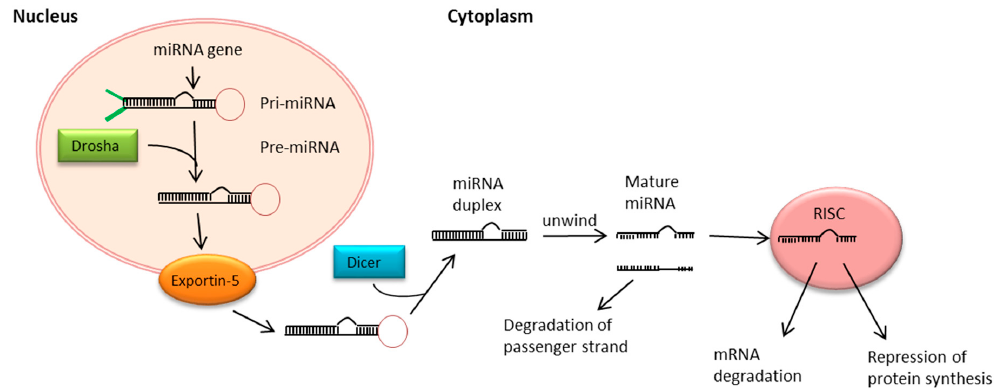
Figure 2. MicroRNA biogenesis and processing pathway. Arrows are indicating the way how microRNAs are processed and how they influence protein expression. Primary-miRNA (pri-miRNA) is transcribed from DNA and cleaved into precursor-miRNA (pre-miRNA), which is exported into the cytoplasm by Exportin-5 for further processing. The mature microRNA (miRNA) strand is assembled into the RNA-induced silencing complex (RISC) to bind mRNA and negatively regulates gene expression by mRNA degradation or by repression of the protein translation (as shown by the arrows pointing away from RISC respectively).